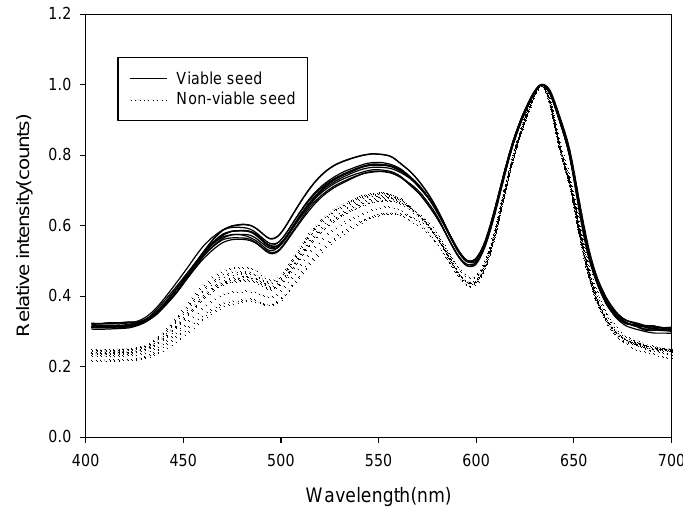
Figure 3. Average spectra with pretreated maximum normalization extracted from images of viable and nonviable pepper seeds illuminated by BL, GL, and RL. 2D Graph